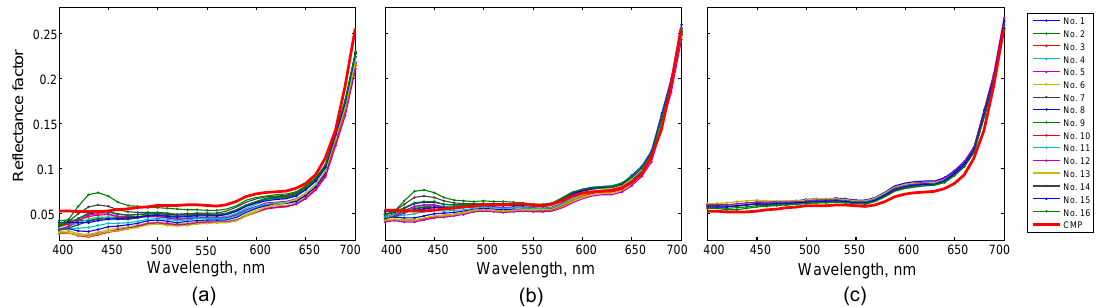
Figure 6. Spectral reflectance curves of a brown patch placed on different background samples. Note that the thick red curve corresponds to the spectral reflectance measured by a spectrophotometer. ( a ) Original reflectance curves. ( b ) Reflectance curves corrected in Stage I. ( c ) Reflectance curves corrected in Stage